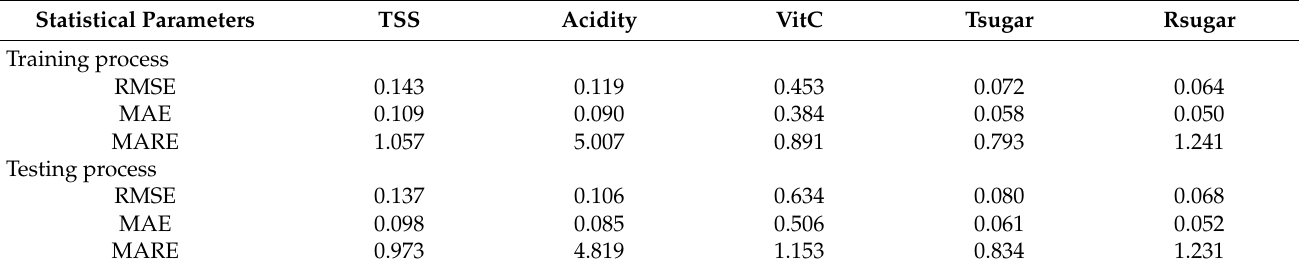
Figure 4. Comparison between experimental and predicted values of total soluble solids (TSS), acidity, vitamin C (VitC), total sugars (Tsugar), and reducing sugars (Rsugar) using ANN and MLR models during training process. Table 6. Statistical performance of the developed ANN model for total soluble solids (TSS), acidity, vitamin C (VitC), total sugars (Tsugar), and reducing sugars (Rsugar) for the training and testing processes.